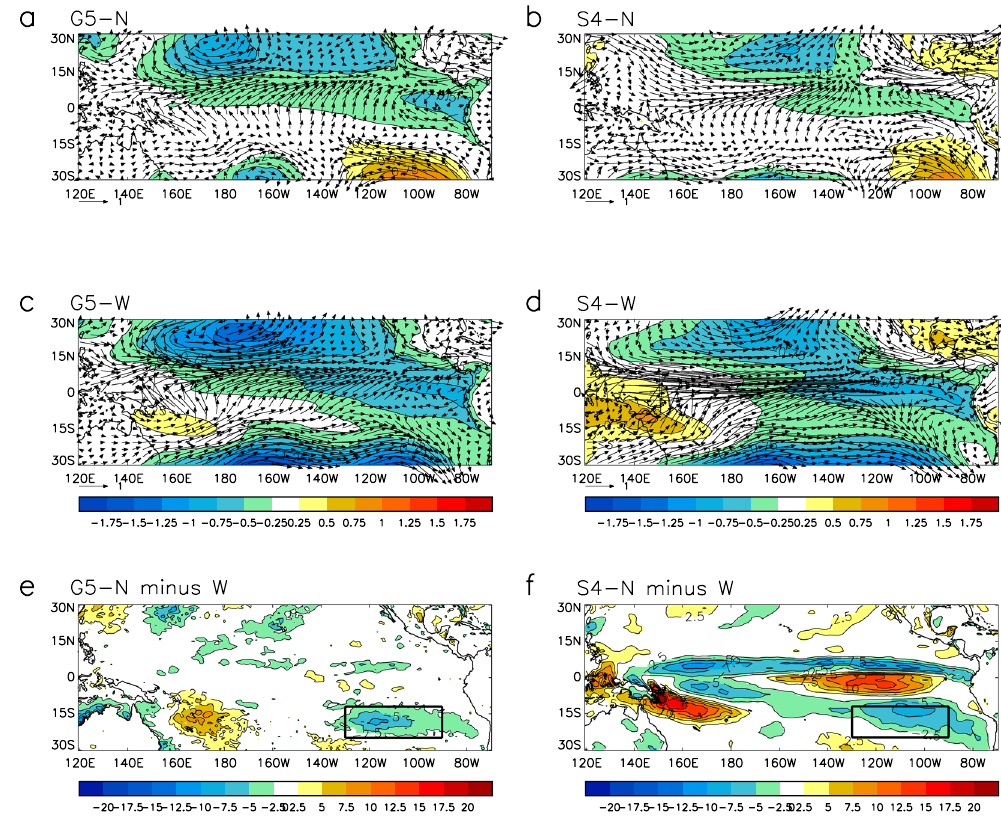
( b ) ‘neutral’ S4 members, ( c ) ‘warm’ G5 members, ( d ) ‘warm’ S4 members, and difference in latent heat flux (downward positive) for ‘neutral’ minus ‘warm’ cases for ( e ) G5 and ( f ) S4. Categories for composites are as defined in Fig. 2. Boxes show the southeast Pacific area (130°W-90°W, 12°S-25°S). Figure was created using IDL8.2 (http://www.harrisgeospatial.com/SoftwareTechnology/IDL.aspx), Met Office (in-house) release